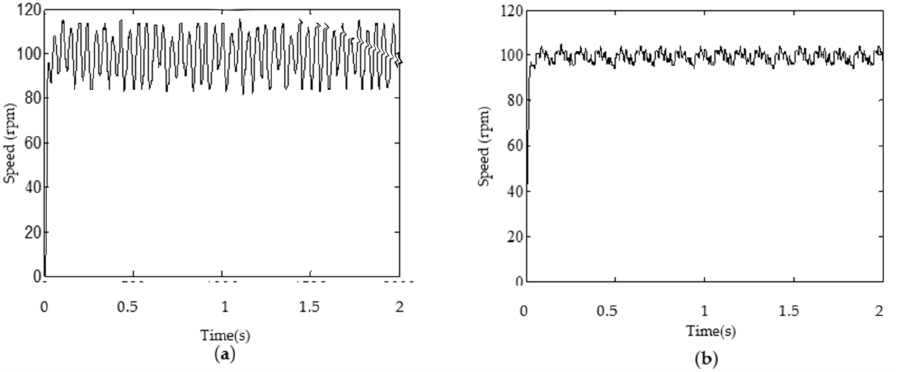
Figure 8. ( a ) The experimental speed response curve of tracking the aim speed 100rpm under the MFSMC strategy; ( b ) The experimental speed response curve of tracking the aim speed 100 rpm under the proposed MFSTNLSMC strategy.